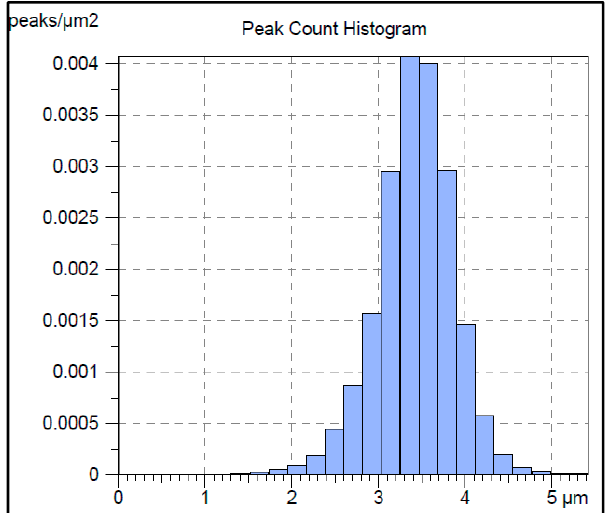
Figure 1. Distribution of uncoated gear teeth asperities.